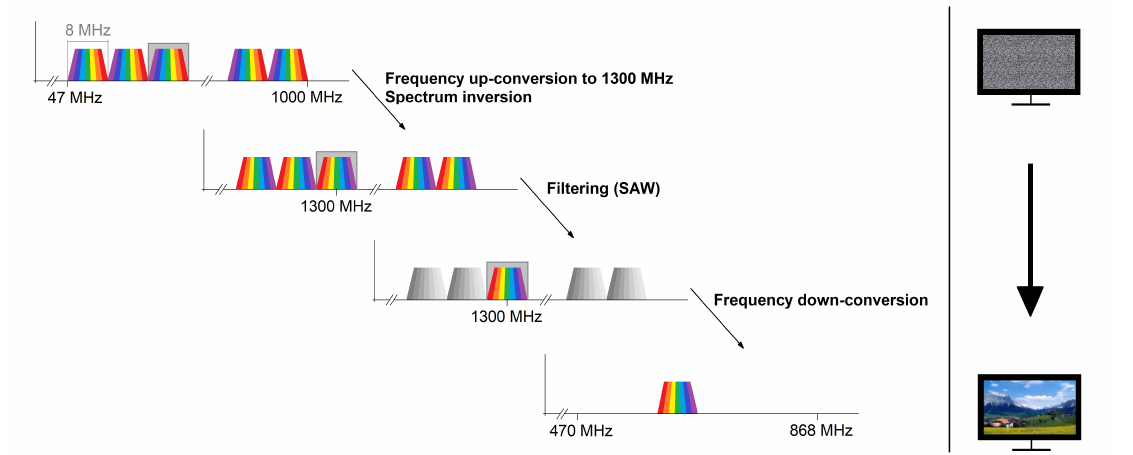
Figure 3. Operation of the reconfigurable RF converter. A DVB-T signal sent in a triple-play scheme over GPON and encrypted using spectrum inversion is up-converted, inverted in spectrum and filtered for channel selection, and down-converted to be fed into a television set through its antenna